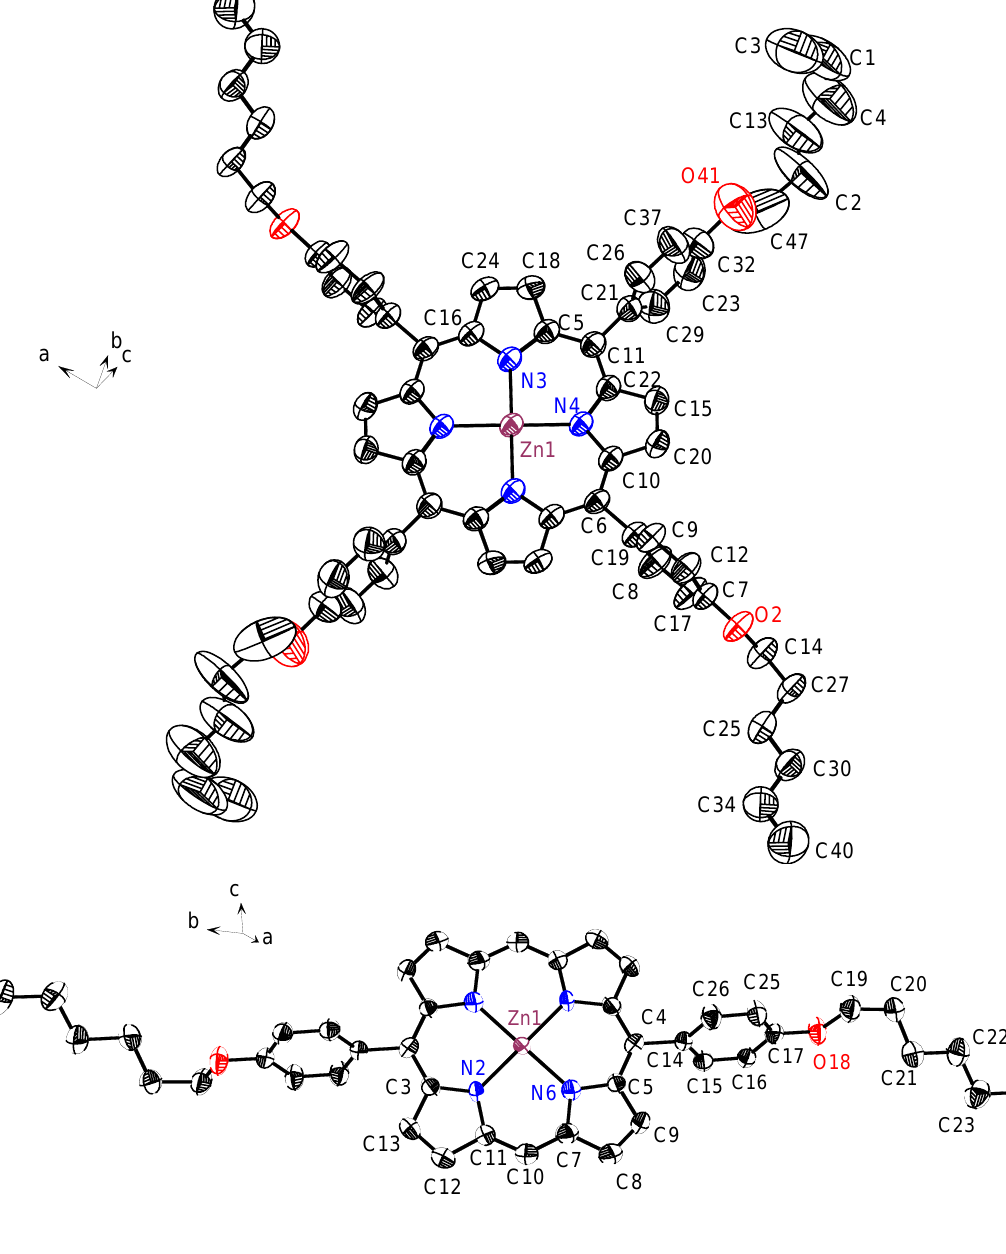
Figure 2. ORTEP view of complex 4 (top) and 5 (lower), with thermal ellipsoids at the 50% probability level. H-atoms have been removed for clarity (note: the atom numbering is different from Figure 3 and refers to the bond distances and angles of Table